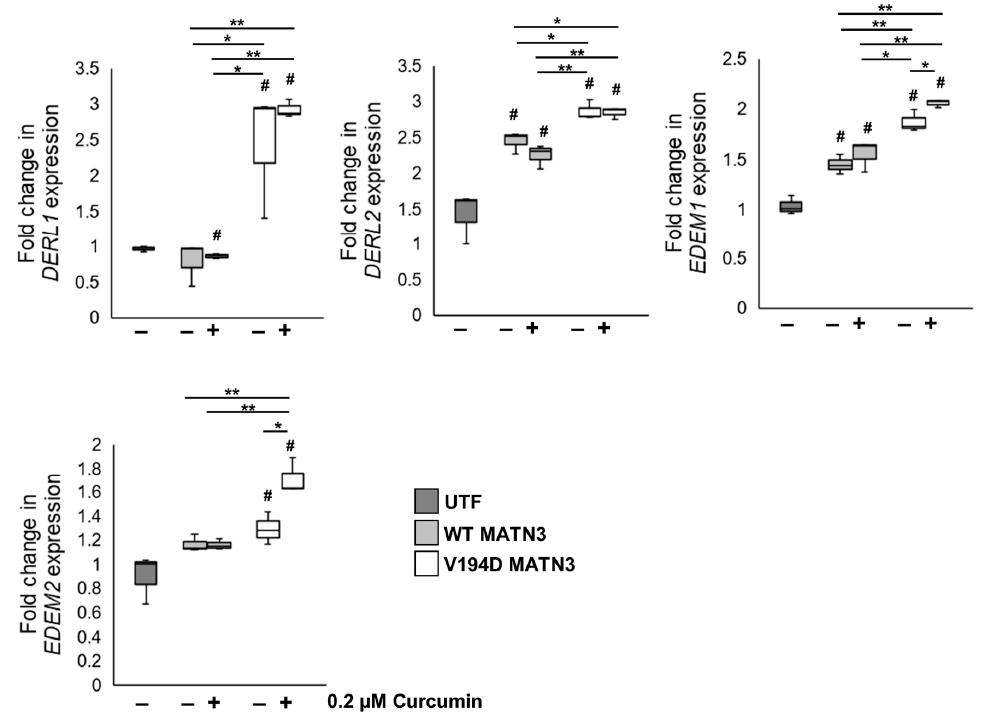
Figure 5. Curcumin promotes the expression of ERAD genes. WT and V194D mutant MATN3- expressing HELA cells were cultured in the presence/absence of 0.2 µM curcumin for 48 h and the expression of ERAD marker genes were analysed by qPCR. Although curcumin treatment of V194D cells significantly upregulates genes encoding EDEM proteins (EDEM1 and EDEM2) that function to recognise and target misfolded proteins for proteasomal degradation, it has no effect on the ex- pression of genes encoding Derlin membrane proteins (DERL1 and DERL2) that function as part of the ER retro-translocon machinery. (Expression normalised to 18S levels. MATN3: matrilin-3, WT: wild-type, UTF: untransfected, # significant to UTF, * p < 0.05, ** p < 0.005, n = 3). Since curcumin has been shown to result in the upregulation of proteasomal genes